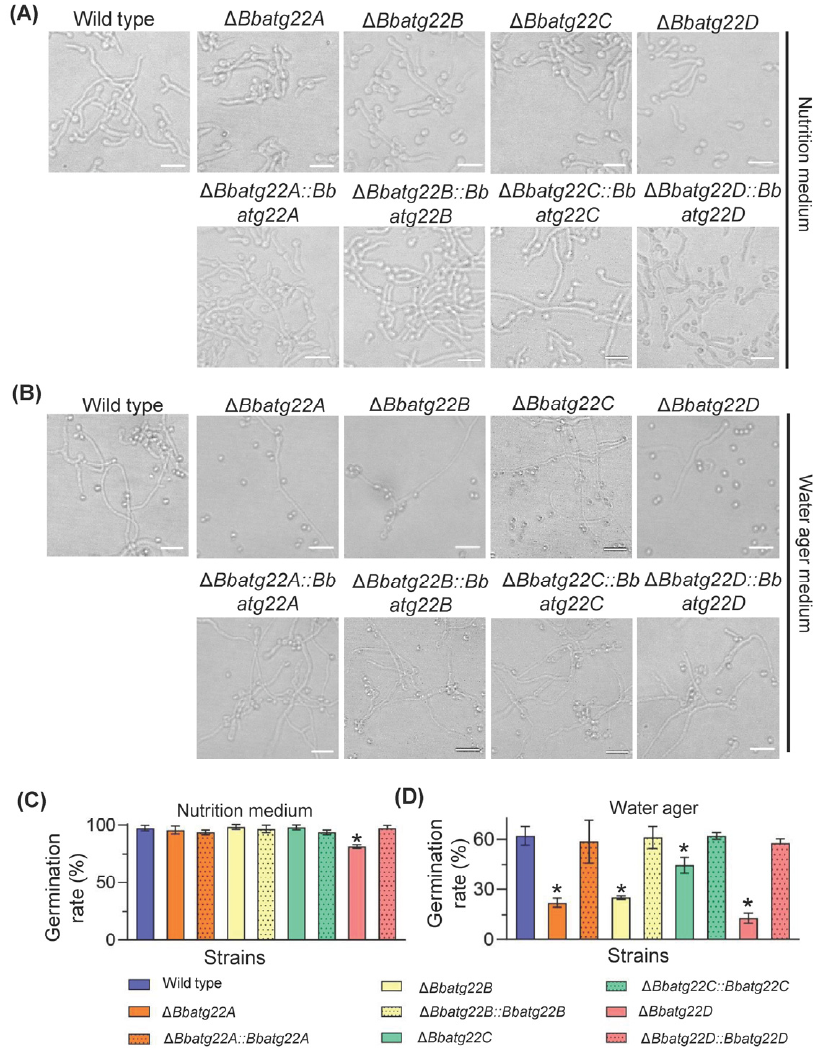
Figure 5. Impacts of gene loss on conidial germination of B. bassiana . Aliquots of 500 µ L suspension (5 × 10 7 conidia/mL) were inoculated on the nutrient medium SPA and water agarose plates and incubated at 25 ◦ C. Incubation time for these two kinds of media was 12 and 24 h, respectively. Microscopic images of germlings formed on nutrient medium and water agarose plates are showed in panel ( A ) and ( B ), respectively. Germination percentages on these two kinds of media are showed in panel ( C ) and ( D ), respectively. Scale bars: 10 µ m. Asterisks on the columns indicate a significant difference between the disruption mutant and the wild type or complemented strains [Tukey’s honestly significant difference (HSD), p < 0.05]. Error bars: standard